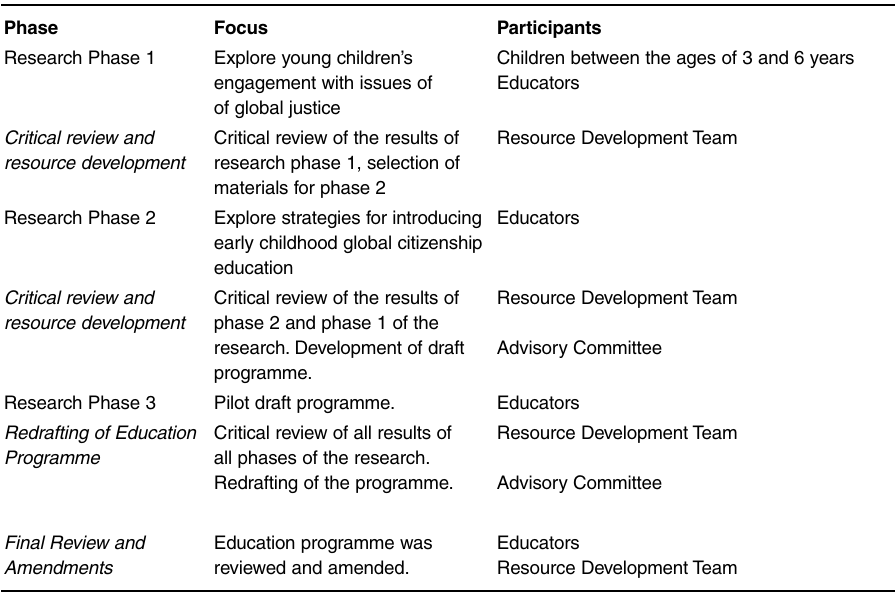
Table 2: Research and Resource Development Process